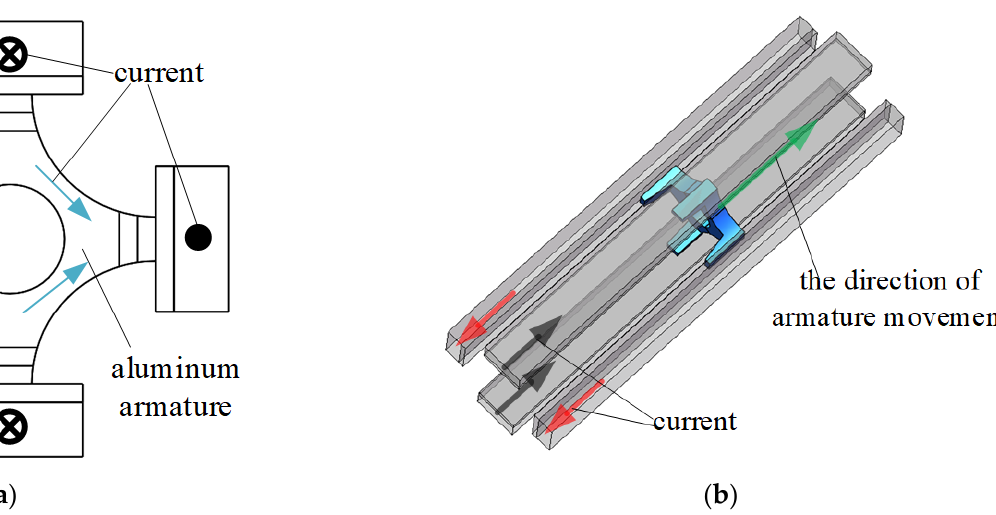
Figure 1 . Model of quadrupole compound orbital electromagnetic launcher: ( a ) top view of the model ( b ) 3-dimensional model.